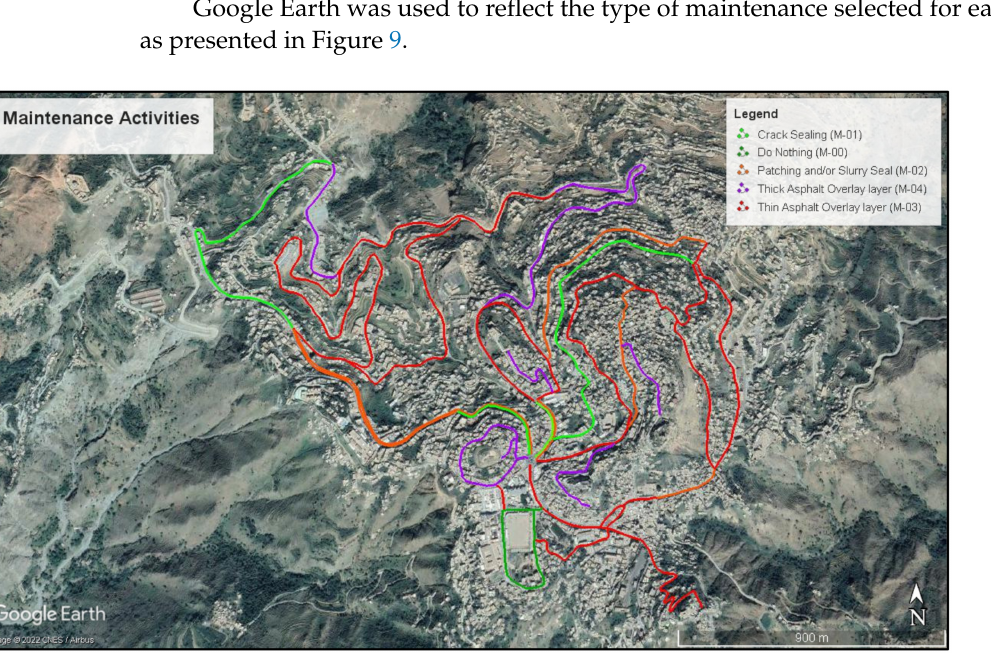
Figure 9. Road maintenance activity map.